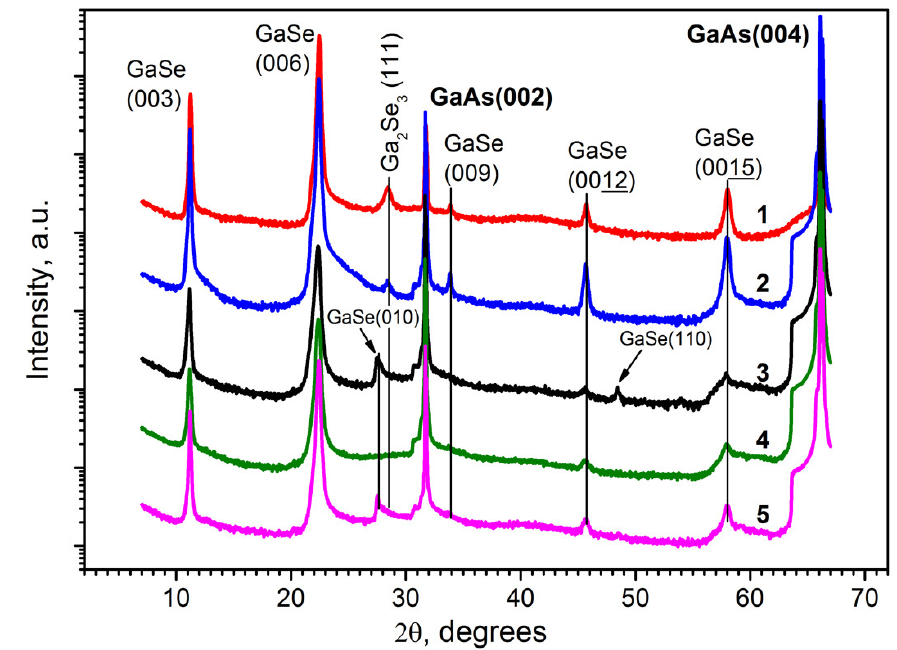
Figure 5. The X-ray powder diffraction patterns of the GaSe layers grown on GaAs(001) substrates. A weak additional peak in the angle range ~28.4°, along the 2θ axis on XRD patterns of the layers grown under strong Se-rich conditions at T S = 400 °C (Curves 1 and 2), is attributed to the inclusions of a Ga 2 Se 3 phase. Curves 1–5 correspond to samples # GS2 , # GS1 , # GS5 , # GS4 , and # GS3 , respectively.